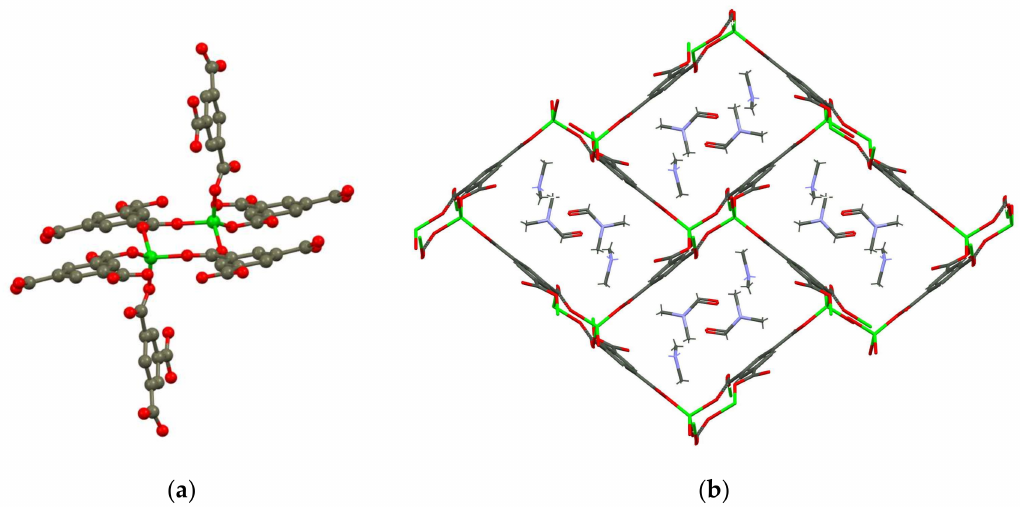
Figure 1. Crystal structure of {Zn-BTC}{Me 2 NH 2+ }. ( a ) The [Zn 2 ( µ -OOC)] 2 structural motif. H-atoms are omitted for clarity; ( b ) The fragment of crystal packing of the {Zn-BTC}{Me 2 NH 2+ } MOF system (Zn = green, O = red, C = grey, N = blue, H =